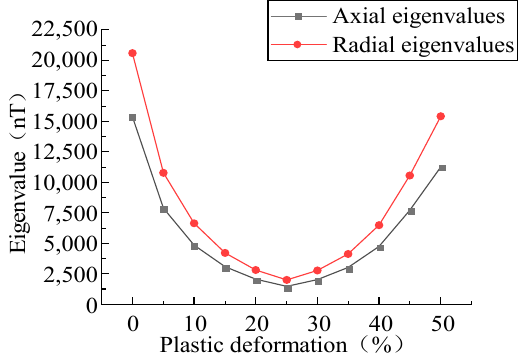
Figure 9. Relationship between plastic deformation and characteristic values.